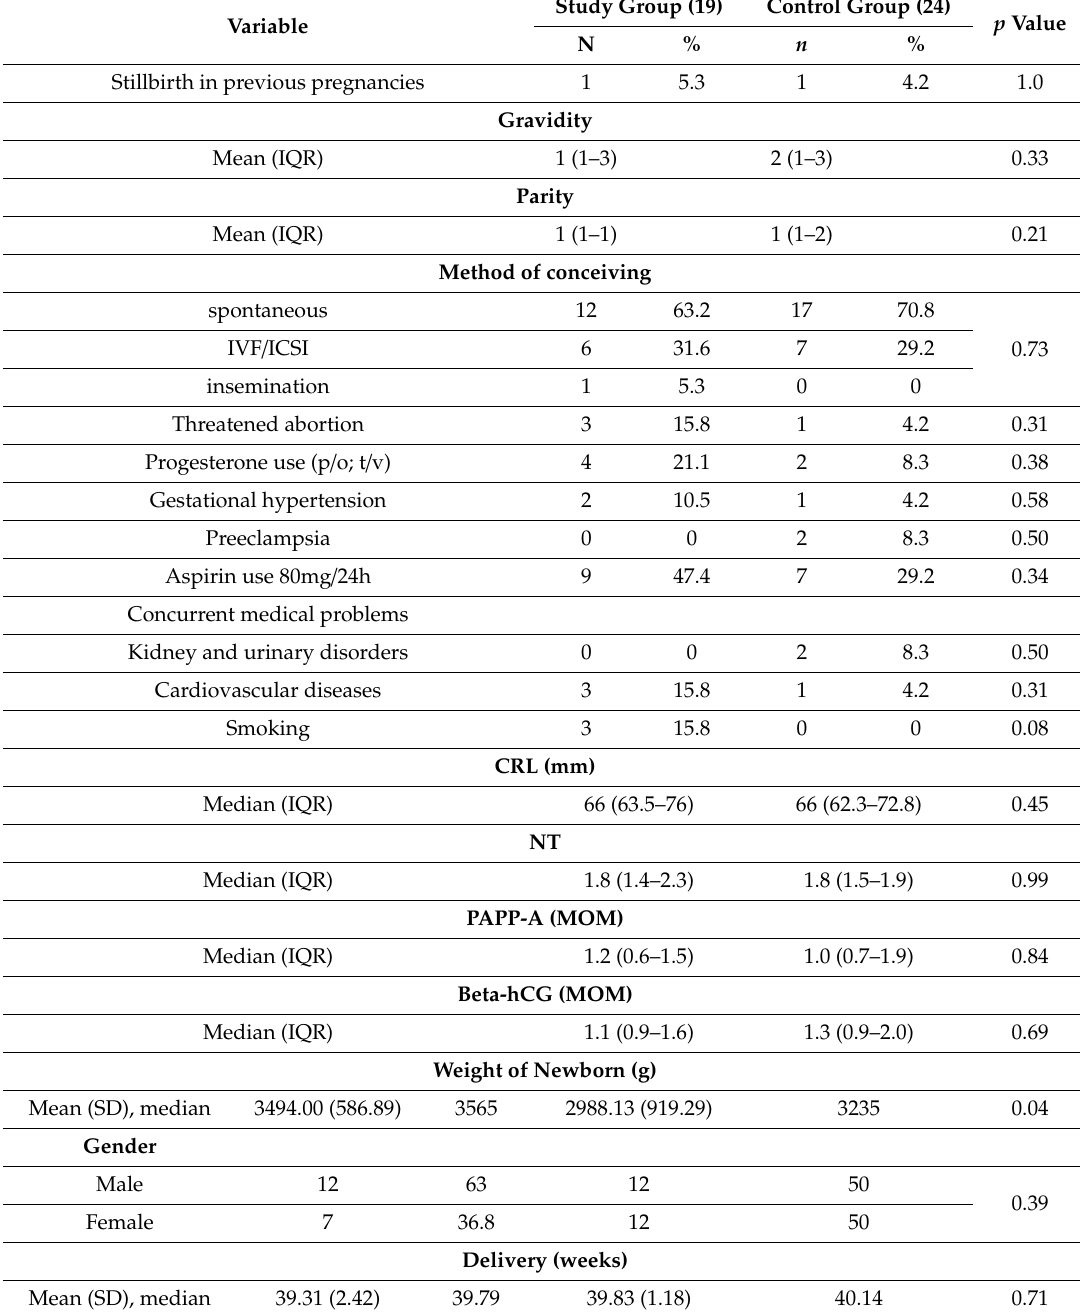
Table 2. Obstetrical characteristics and concurrent medical problems of patients from study and control